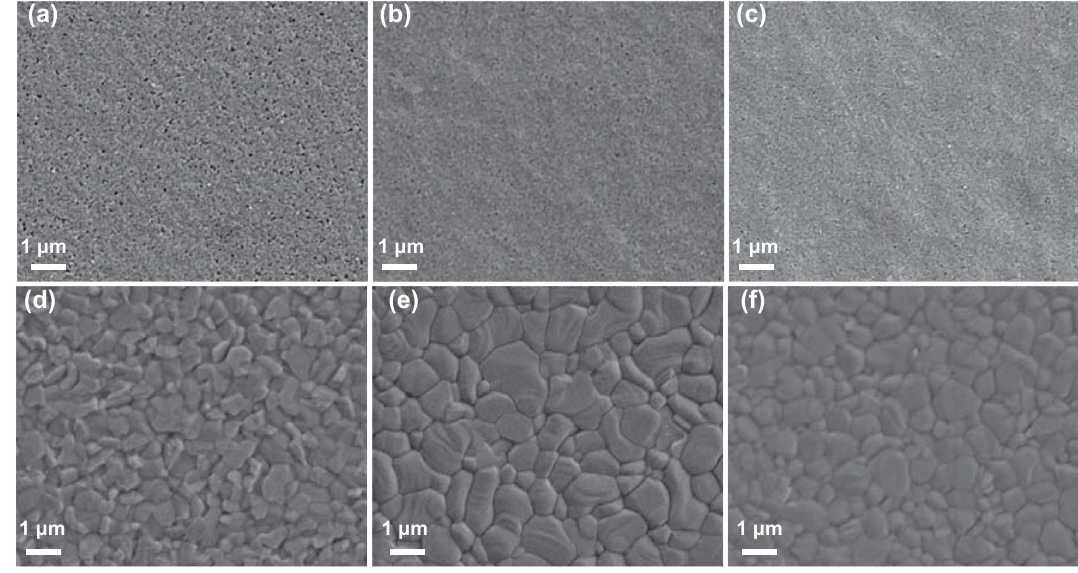
Fig. 3 a–c SEM images of slot-die coated PbI 2 :CsI films under ambient conditions at the different bed temperatures of 60, 70, and 80 °C, respectively. d–f SEM images of slot-die coated perovskite films under ambient conditions at the different bed temperatures of 60, 70, and 80